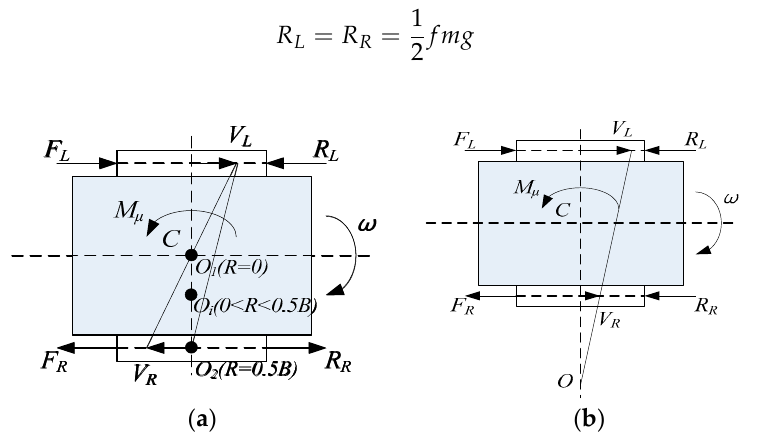
Figure 1. Forces analysis ( a ) R ≤ 0.5 B steering; ( b ) R > 0.5 B steering.